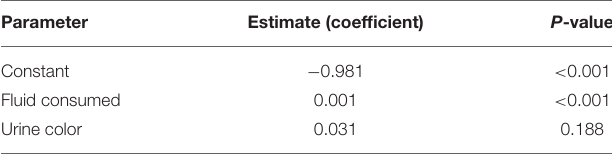
TABLE 1 | Multi-level model summary.